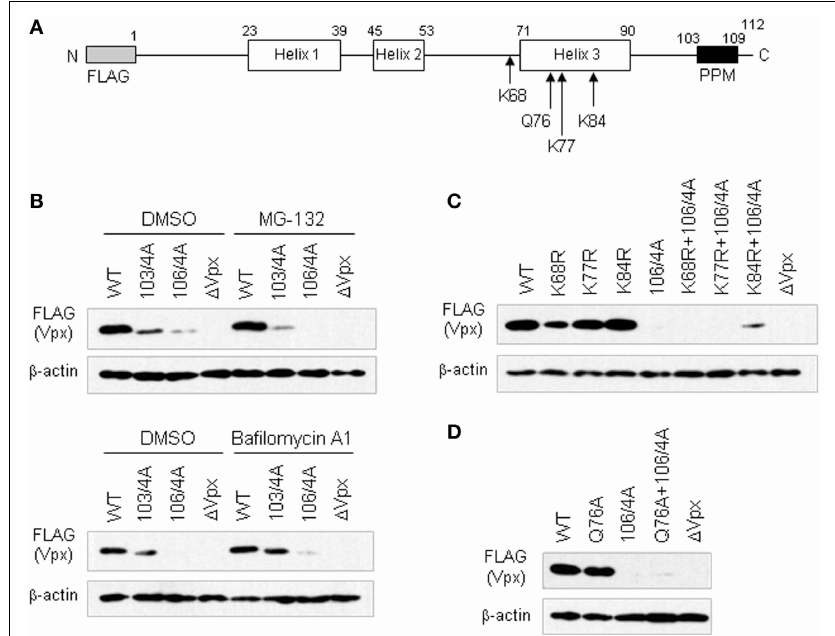
FIGURE 1 | Steady-state levels of various Vpx-PPM mutants in cells as monitored by Western blotting. (A) Structure of the FLAG-tagged HIV-2 GL-AN Vpx construct. Numerals above the schema represent amino acid numbers of the Vpx protein. Positions of lysine and glutamine residues mutated are indicated. (B) Expression of Vpx-PPM mutants in the presence of a proteasome inhibitor MG-132 or a lysosome inhibitor Bafilomycin A1. (C) Expression of lysine-mutants with or without 106/4A mutation. (D) Expression of Q76A mutants with or without 106/4A mutation. For (B) to (D) experiments, 293T cells were transfected with the plasmids indicated, and harvested for Western blotting 24h later. To examine lysosomal and proteasomal degradation processes (B) , 100nM of BafilomycinA1 (Yoshimori et al., 1991) and 7.5 µ M of MG-132 (McCulley and Ratner, 2012) were added at 5 and 16h post-transfection, respectively. WT, pEF-Fvpx; (cid:2) Vpx,